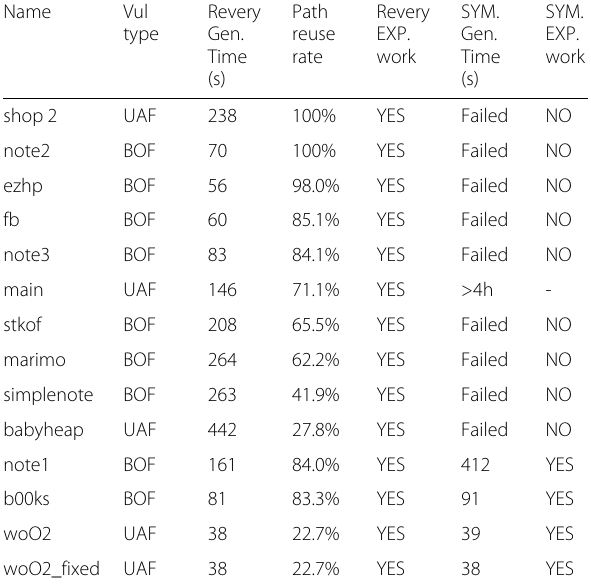
reused from the diverging path, compared to the count of basic blocks in the exploitation path. A higher reusing rate indicates that the stitching point is better for exploit generation. As shown in the table, more than half of the programs has a path reusing rate higher than